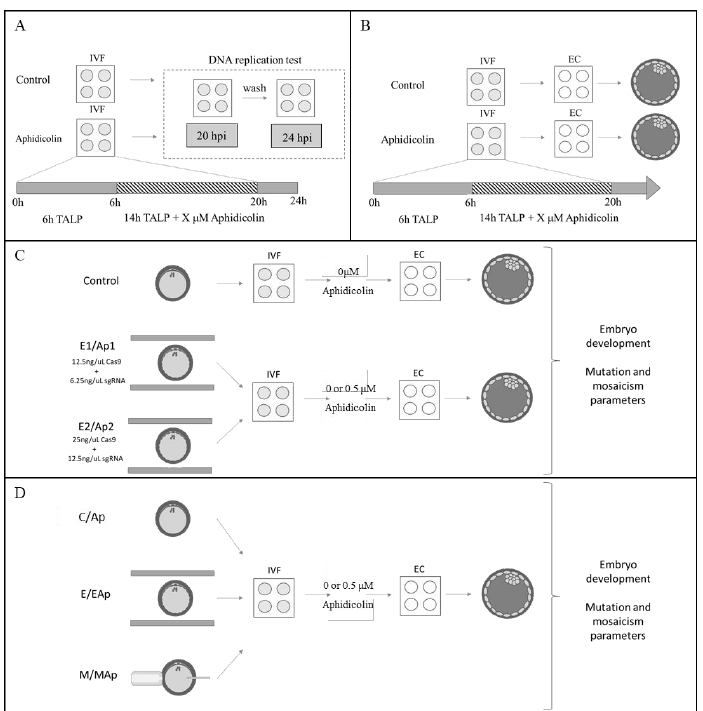
Figure 2. Experimental design. ( A ) Effect of aphidicolin on reversible inhibition of DNA replication. In vitro-derived zygotes (IVF) were cultured with different concentrations of aphidicolin or without aphidicolin from 6 to 20 h after insemination (hpi). Half of them were fixed 20 h after insemination and the other half were cultured in NCSU23a medium and fixed 4 h later. DNA replication was evaluated in all groups. ( B ) Effect of aphidicolin on porcine embryo development. IVF zygotes were cultured during the same time conditions with different concentrations of aphidicolin and then sub- jected to embryo culture (EC) for 6.5 days until blastocyst stage. ( C ) Effect of aphidicolin and ribo- nucleoprotein (RNP) concentration on gene editing. Oocytes were electroporated with two concen- trations of RNP against TPCN1 and zygotes were in vitro cultured for 6.5 days until blastocyst stage in the presence or absence of aphidicolin. Embryo development and mutation parameters were eval- uated. ( D ) Effect of aphidicolin and methodology in gene editing. Oocytes were electroporated or microinjected with RNP against TPCN1 and zygotes were in vitro cultured in the presence or ab- sence of aphidicolin. Embryo development and mutation parameters were evaluated at 6.5 days after culture. Six groups were used for this experiment: C (control), Ap (0.5 μM of aphidicolin treat- ment), E (electroporated), EAp (electroporated with 0.5 μM of aphidicolin treatment), M (mi- croinjected), and MAp (microinjected with 0.5 μM of aphidicolin treatment). 2.1. Effect of Aphidicolin on Reversible Inhibition of DNA Replication in Porcine Zygotes As shown in Figures 2A and 3, incubation of zygotes with aphidicolin at different concentrations reduces the degree of DNA replicated at 20 hpi with significant differences ( p < 0.05) with respect to control embryos. The reduction in DNA replication increased with the concentration of aphidicolin. Furthermore, all zygotes in all groups recovered